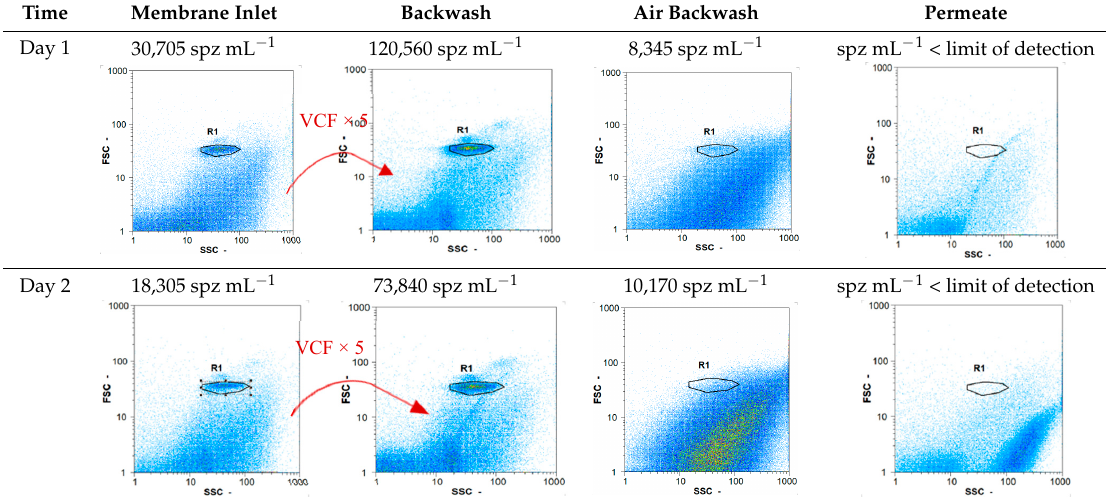
Table 4. Flow cytometry of spermatozoa—(J = 60 L h − 1 m − 2 and t filtration = 30 min for chronic pollution).